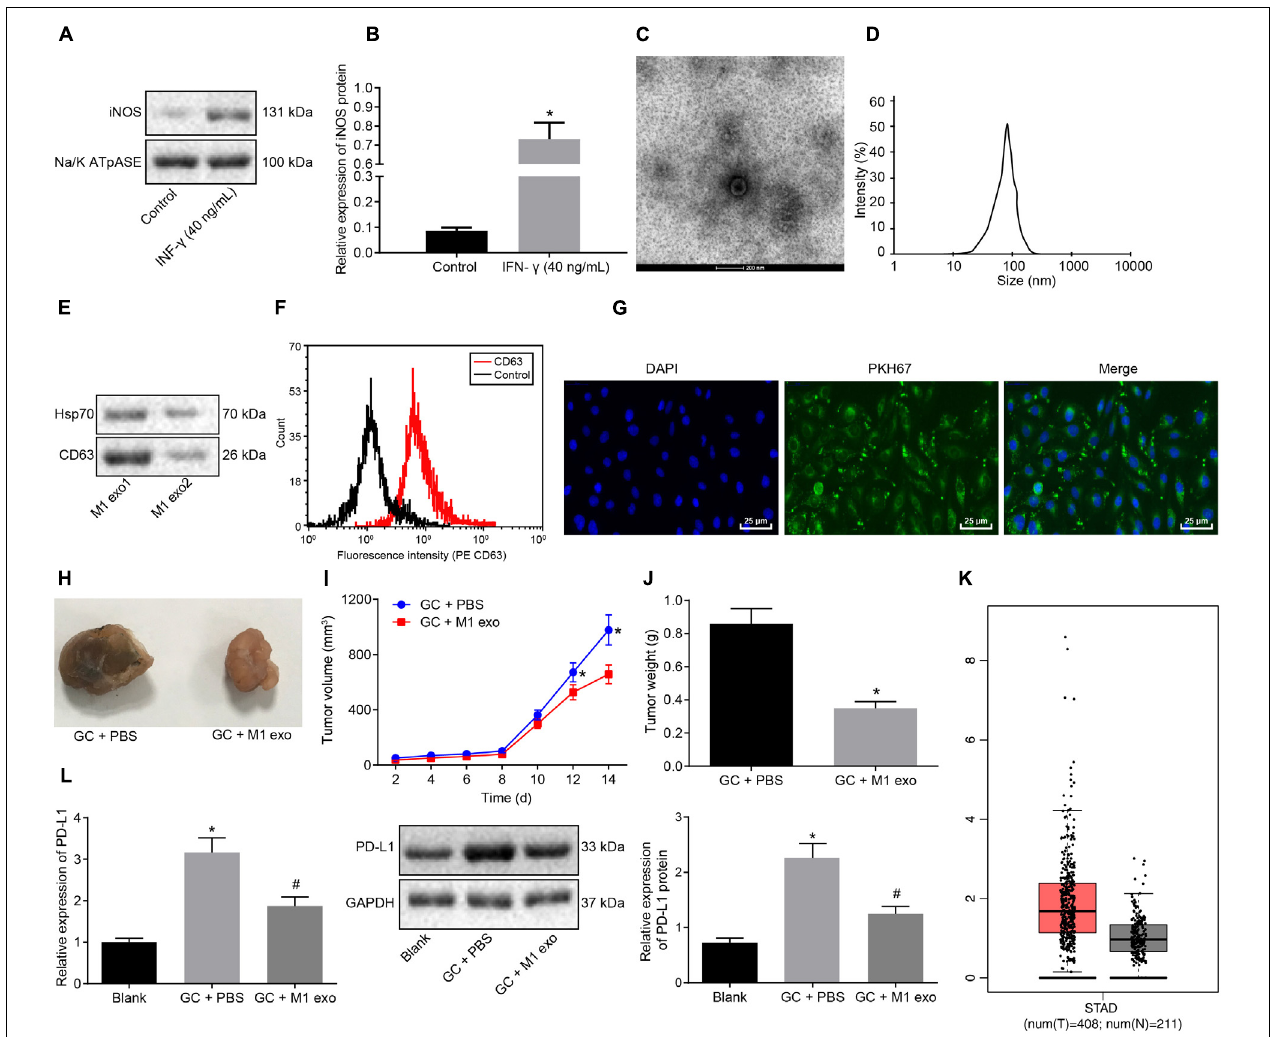
FIGURE 2 | Exosomes derived from M1 macrophages suppress GC progression. (A) Western blot analysis of the cell surface marker iNOS protein expression in LPS (100 ng/ml) + IFN- γ (20 ng/ml)-induced macrophages (M1 macrophages) normalized to Na/K ATPase. (B) M1 macrophage membrane proteins quantified by image J and normalized with Na/K ATPase as well as statistics of iNOS gray value. (C) TEM observation of M1 macrophage-secreted exosomes (5,000 × ). (D) Dynamic light scattering detection of the diameter of exosomes. (E) Western blot analysis of the exosome surface markers (CD63 and HSP70) protein expression in M1 macrophages. (F) Flow cytometry of the exosome surface marker CD63 level. (G) Uptake of PKH76-labeled exosomes by GC cells was analyzed under a confocal fluorescence microscope (400 × ). (H) Tumor morphology in model mice with GC ( n = 5). (I) Tumor volume in model mice with GC ( n = 5). (J) Tumor weight in model mice with GC ( n = 5). (K) Box plots of PDL1 expression in GC samples from TCGA analyzed by GEPIA (http://gepia.cancer-pku.cn/), wherein the left is GC tissues and the right is normal tissues, and the vertical axis is log2 [tags per million (TPM) + 1] (all PDL1 levels were normalized by TPM). (L) Western blot analysis of PD-L1 protein expression in model mice with GC normalized to GAPDH after protein quantitation by Image J ( n = 5). * p < 0.05 compared with macrophages without the induction of IFN- γ or M1 exosome or mouse GC models without any treatment; # p < 0.05 compared with mouse GC models treated with PBS. Measurement data was representative of three independently conducted experiments and expressed as the mean ± standard deviation. Comparisons between two groups are analyzed by non-paired t test, and comparisons among multiple groups are analyzed by one-way ANOVA. Post hoc test is conducted using Tukey’s